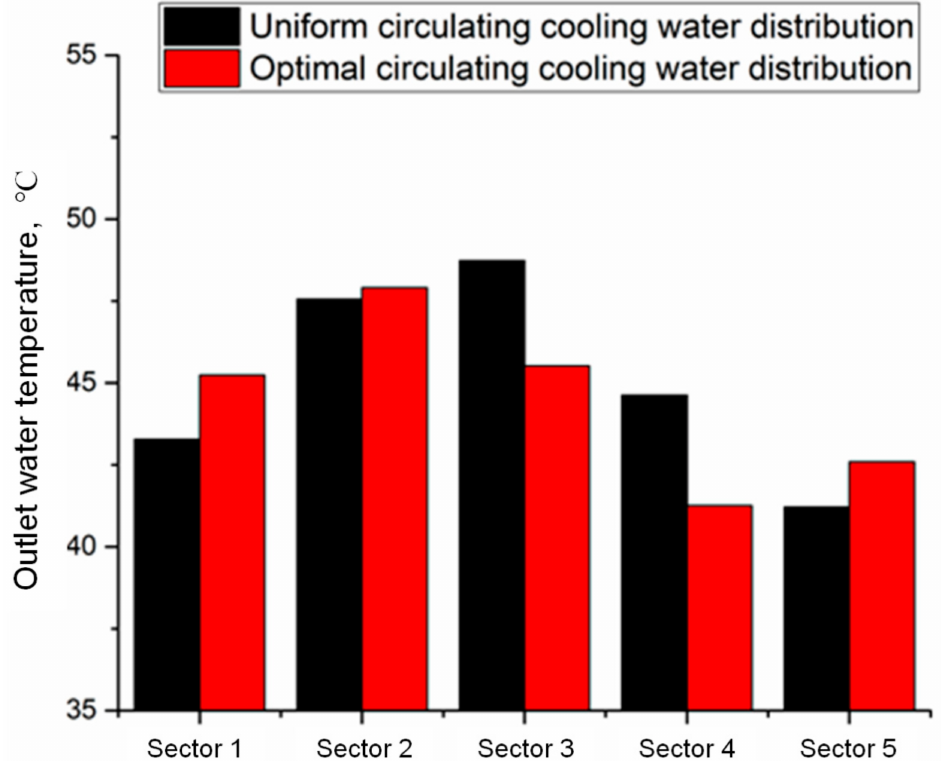
Figure 11. Outlet water temperatures of different sectors under ambient temperature 24 ◦ C and crosswind speed 6 m s − 1